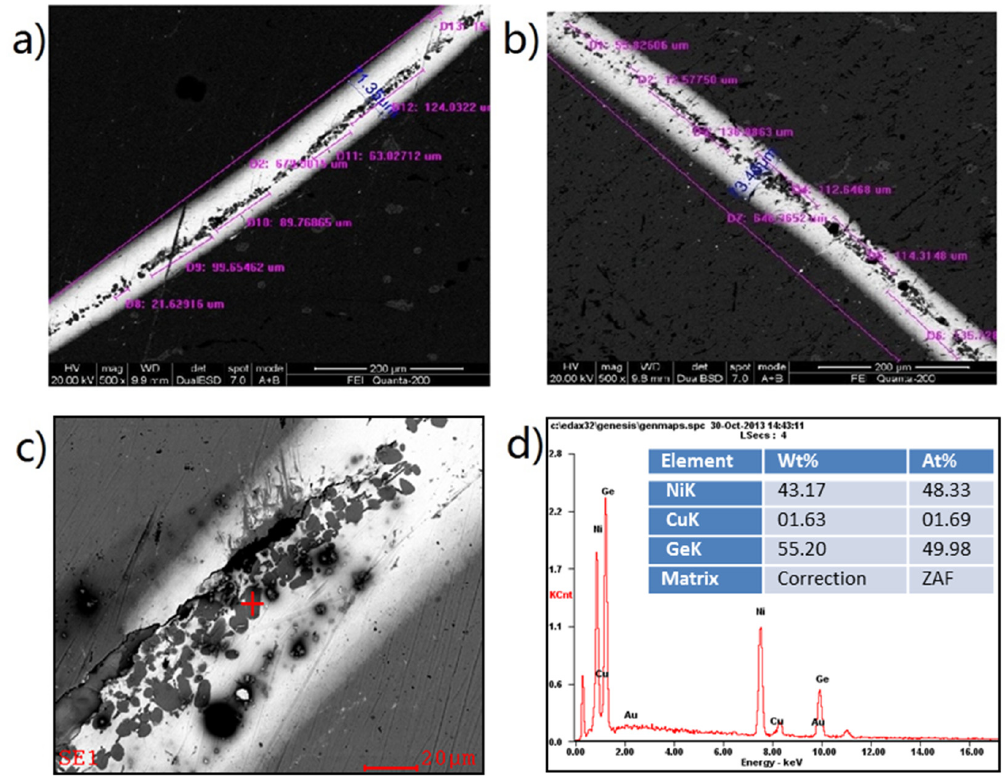
Figure 14. Cross-sectional SEM morphologies of micro defects ( a – c ) and EDS spectrum ( d ) for the sample brazed for 30 min holding at 535 °C.